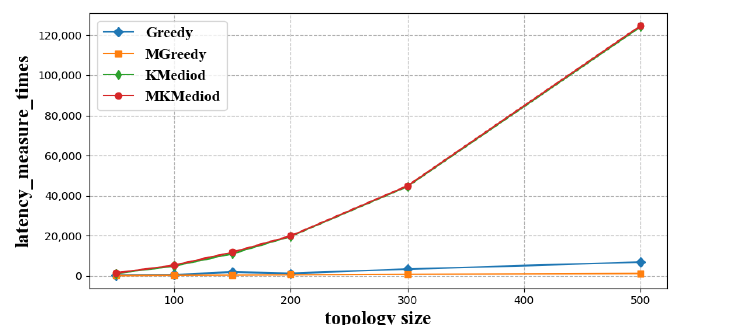
Figure 4. Latency measure times of each algorithm with different network